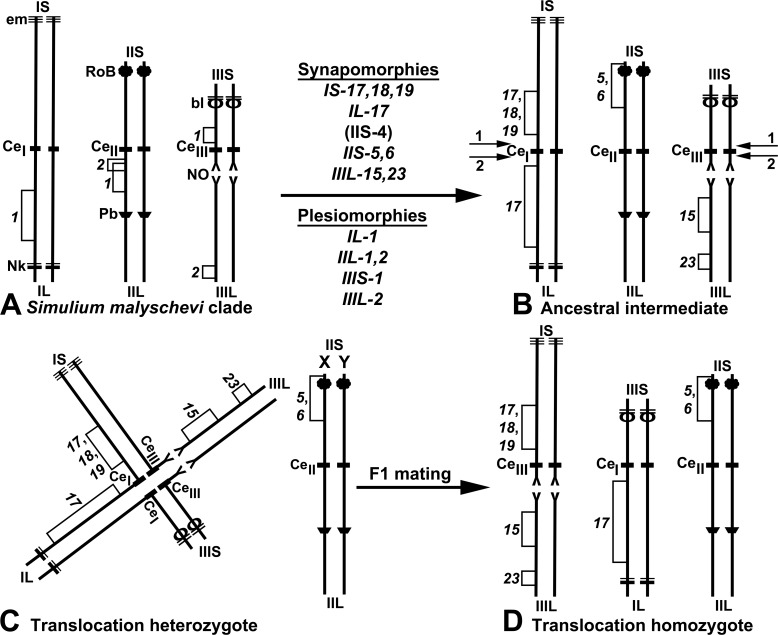
Schematic derivation of the monocentric translocation homozygotes that define the Simulium cholodkovskii lineage.Diagnostic landmarks are given on idiograms for short (S) and long (L) arms of the three chromosomes (I, II, III). Both homologues of each chromosome are shown; bl = blister with 2 heavy bands, Ce = centric region containing putative centromere, em = end marker, Nk = neck, NO = nuclear organizer, Pb = parabalbiani, RoB = ring of Balbiani. Fixed inversions are italicized and bracketed on the left side of each chromosome; polymorphic inversions are in standard type and bracketed on the right side. A. Standard chromosomal complement, showing characteristic inversions of the Simulium malyschevi clade (IL-1, IIL-1, IIL-2, IIIS-1, and IIIL-2) from which the sequences of the S. cholodkovskii lineage are derived. From the ancestral intermediate through present-day members of the lineage (B–D), these inversions carry through as plesiomorphies, but are not shown in subsequent idiograms. B. Hypothetical intermediate of the Simulium cholodkovskii lineage, with characteristic fixed inversions established before the translocation event. Arrows 1 and 2 represent proximal and distal breaks, respectively, in the centric regions of chromosomes I and III. C. Derivation of a monocentric translocation heterozygote expressed as one of two possible scenarios: 1) As shown, chromosomal breaks occur in the proximal centric regions of chromosomes I and III (arrows 1 in Fig 10B) such that IS joins with CeIII plus IIIL and IL plus CeI joins with IIIS, giving rise to translocation heterozygote progeny (first generation). 2) (Not shown) chromosomal breaks occur in the distal centric regions of chromosomes I and III (arrows 2 in Fig 10B) such that IS plus CeI joins with IIIL and IL joins with CeIII plus IIIS. IIS is shown as the putative sex arm (X, Y). D. Monocentric translocation homozygote formed from an F1 mating. In our model, the first appearance of translocation homozygotes occurs in the F2 as a result of matings between F1 translocation males and females.